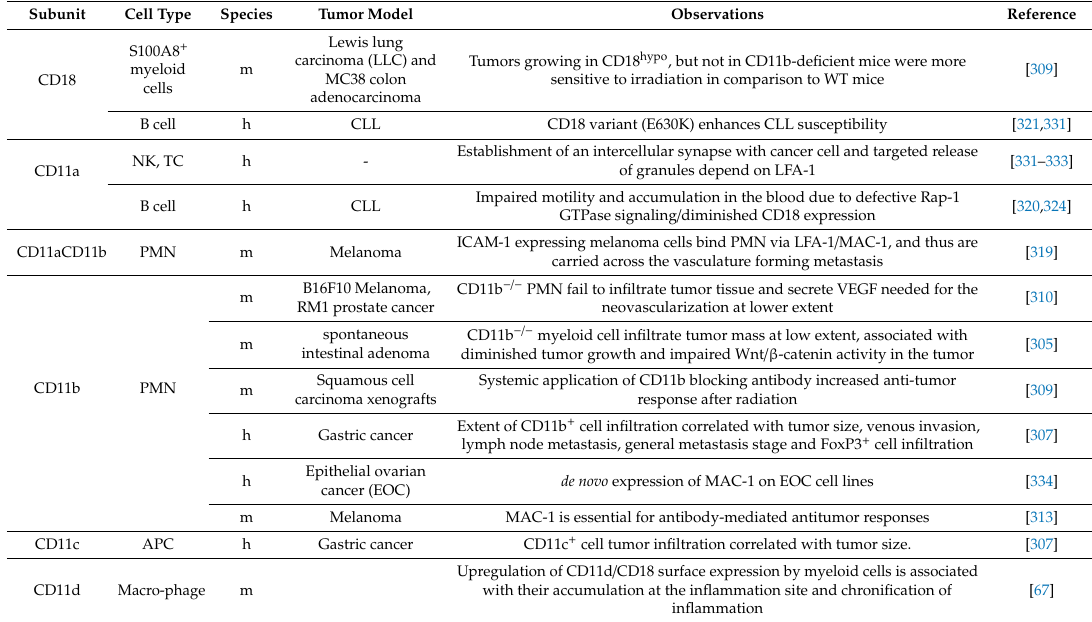
Table 2. The role of β 2 integrins in tumor